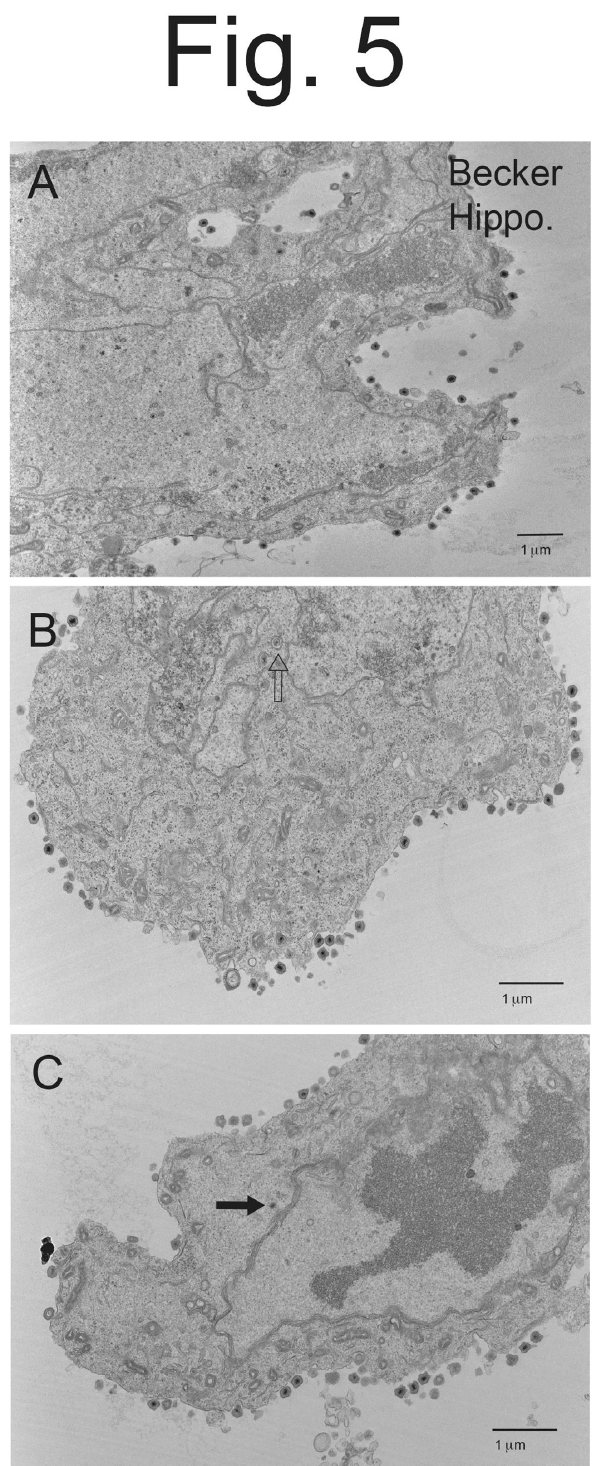
Figure 5. Electron micrographs of rat hippocampal neurons infected with wild-type PRV Becker. Hippocampal neurons were plated on lysine/laminin-coated Thermanox coverslips and infected with PRV Becker for 10–12 h then fixed before processing the Thermanox blocks with cells for EM. Panel ( A ) shows ample quantities of enveloped virions on the surfaces of neurons. Panel ( B ) also shows numerous surface enveloped virions, as well as rarer examples of partially enveloped and enveloped capsids (empty arrow). Panel ( C ) shows cell surface enveloped particles as well as an unenveloped capsid in the cytoplasm (solid